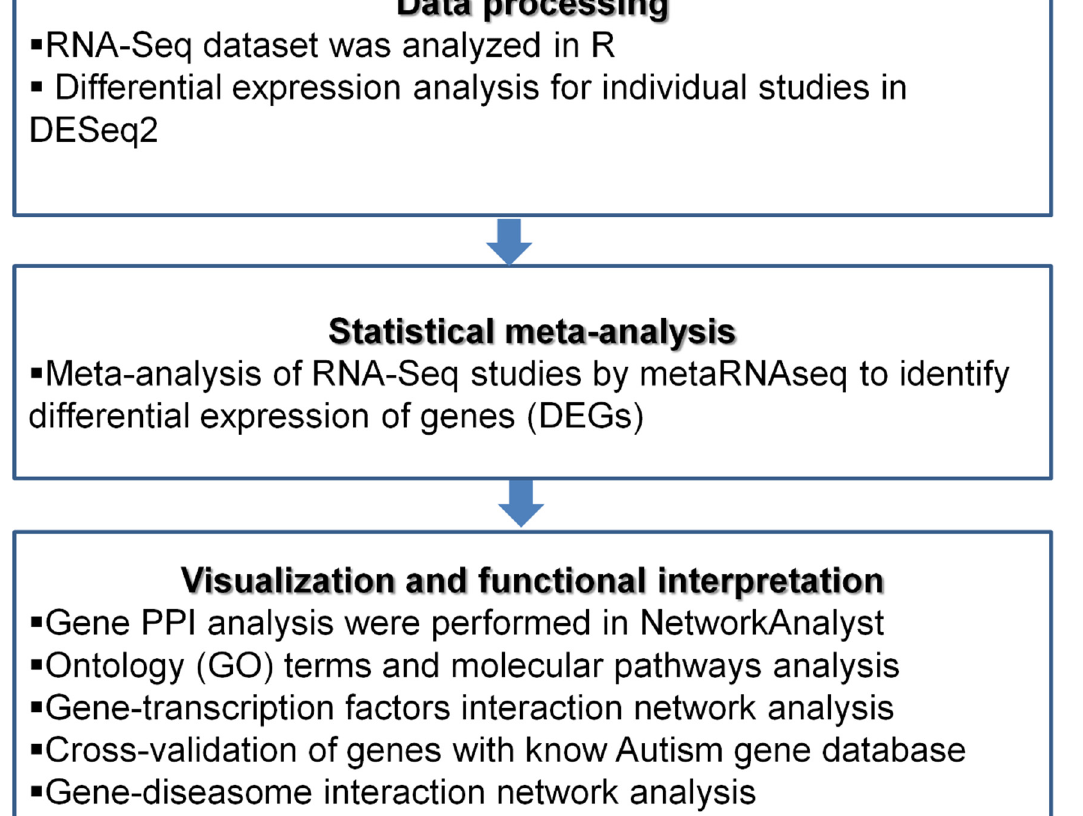
Figure 1. Workflow of data selection and meta-analysis. The Gene Expression Omnibus was searched for human post-mortem RNA-Seq gene expression profiling datasets of brain cortex from autism spectrum disorder patients. Functional analysis was performed on the data obtained from the meta-analysis of the selected datasets.